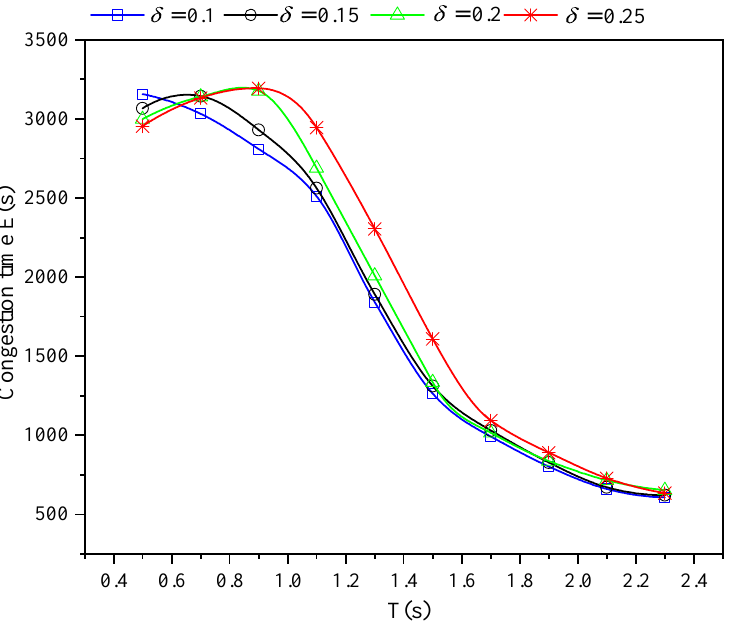
Figure 5. Congestion time E for varying T and perceptual error size δ in a completely CAV scenario with an independent on-board sensor perception